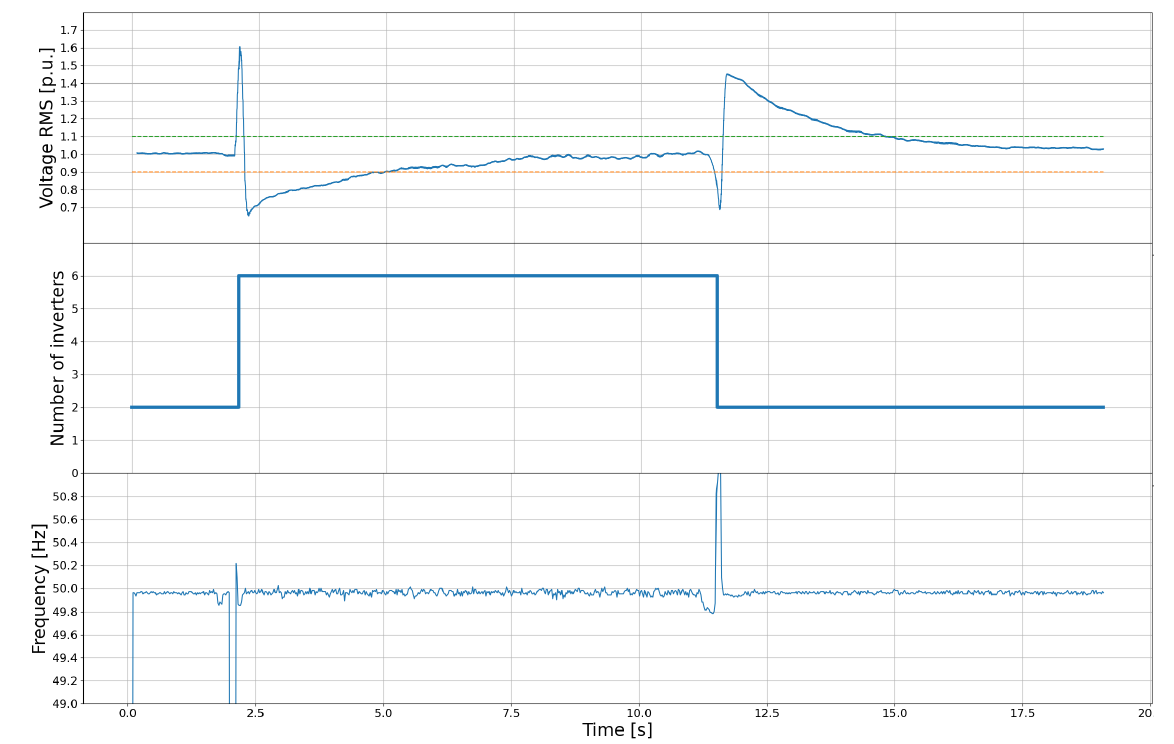
Figure 11. Connection and removal of neighbor MG with twice the power of the first